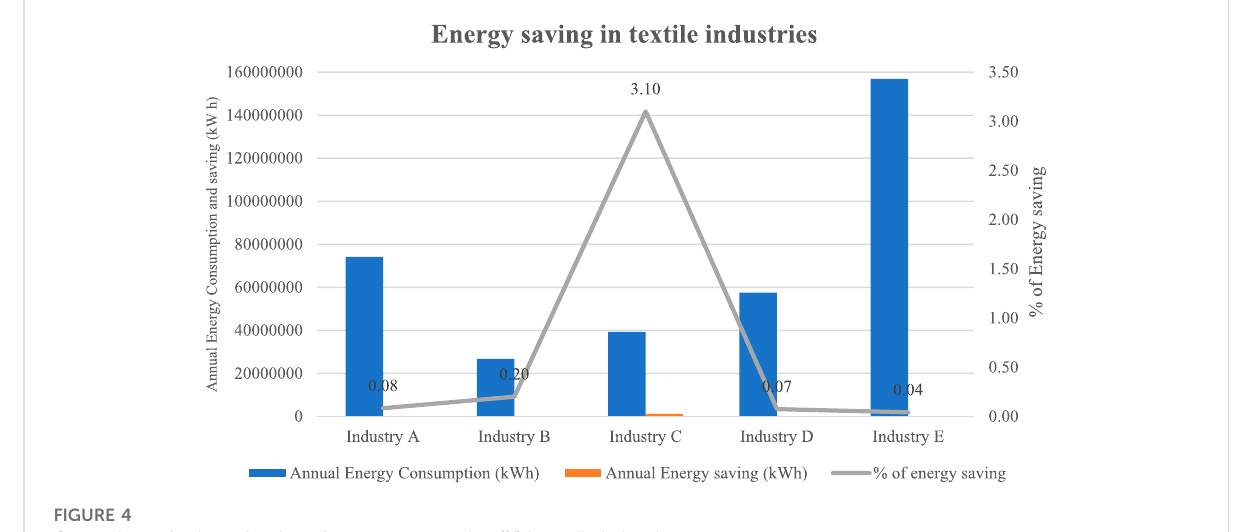
FIGURE 4 Comparison of volume fraction of energy conservation (%) in textile